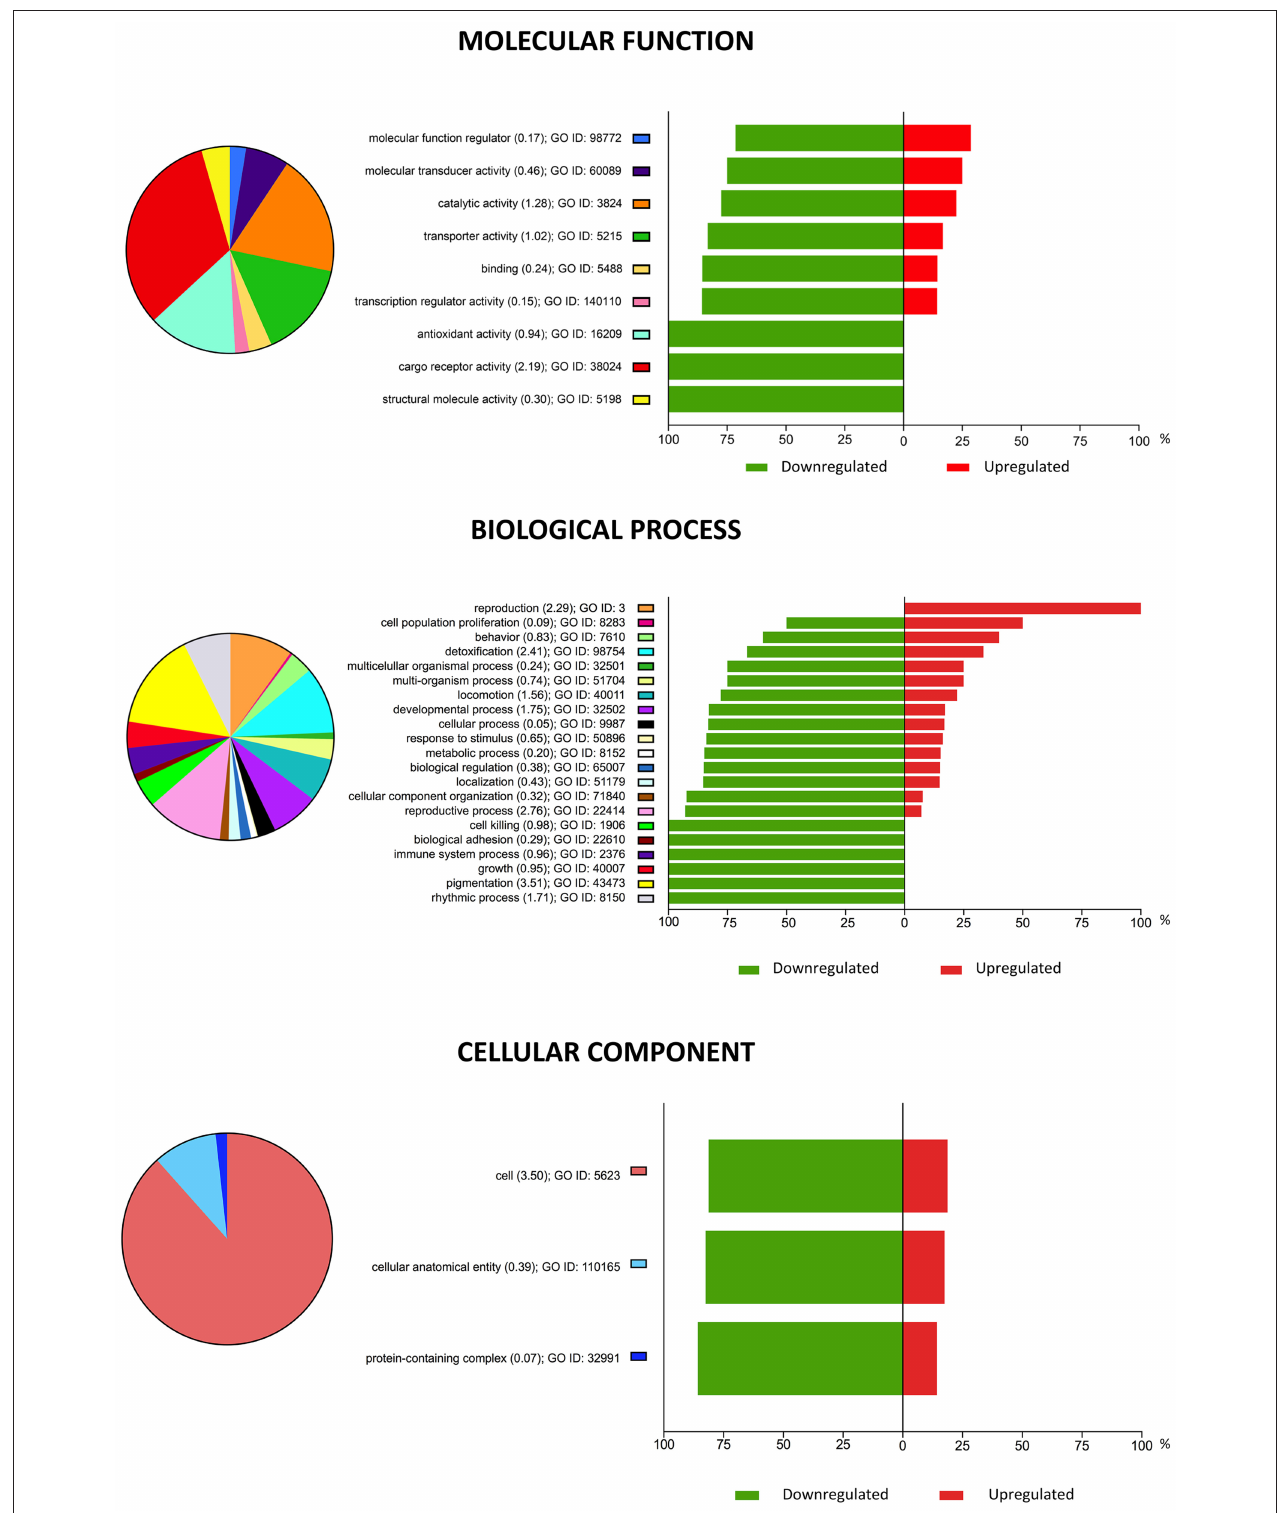
FIGURE 3 | Pie chart representation of Gene Ontology (GO) for genes differentially expressed in vitrified morulae compared to control embryos, summarized by molecular function, biological processes, and cellular component. The plots show the proportion of differentially expressed genes (DEGs) within each functional group. Upregulated DEGs are shown in red and downregulated DEGs in green. Functional categories were analyzed based on the GO annotations of the KEGG classification system; the enrichment values of each GO term are shown in parentheses indicate.